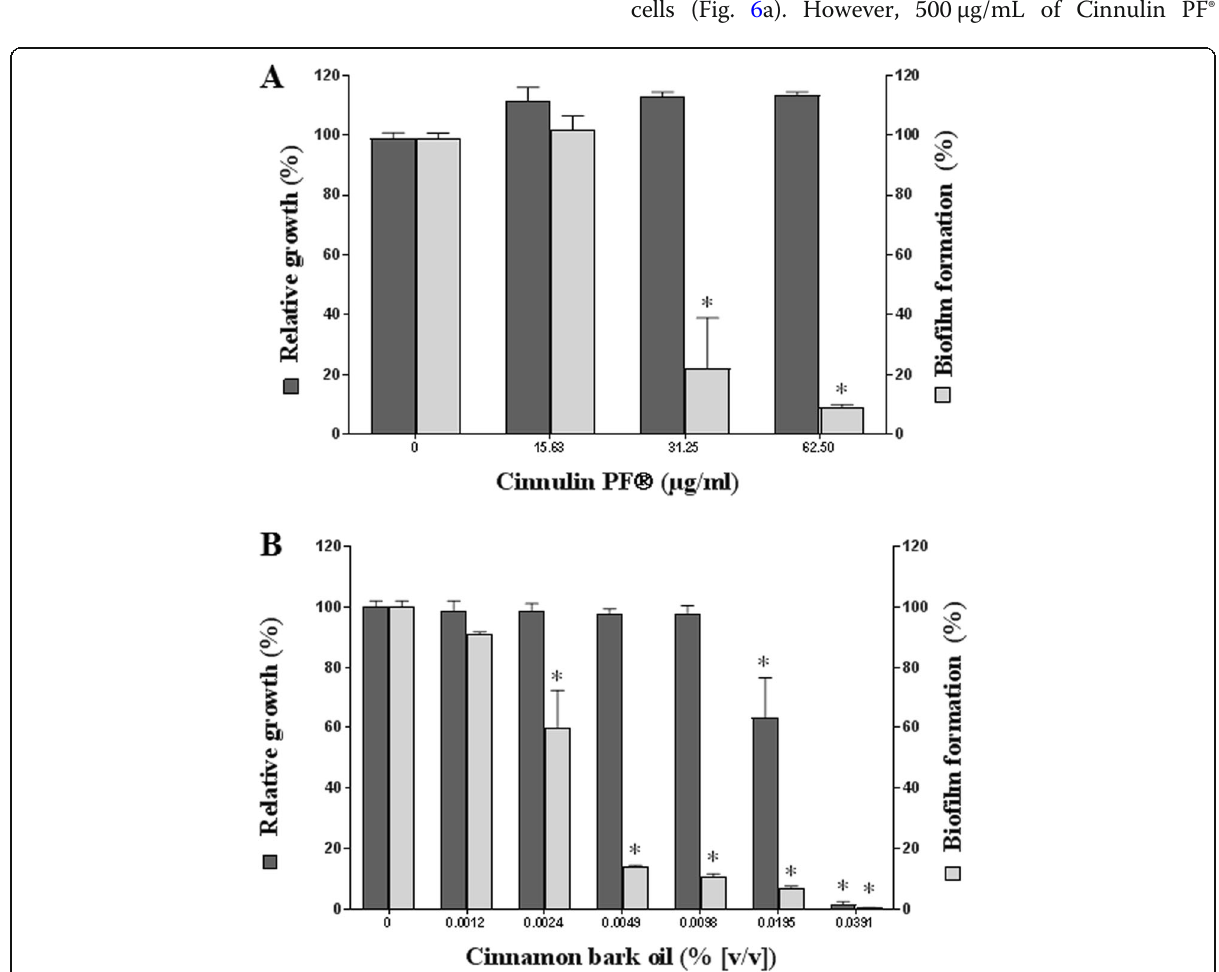
Fig. 2 Effect of Cinnulin PF® (panel a ) and cinnamon bark oil (panel b ) on the growth and biofilm formation of C. albicans ATCC 28266. A value of 100% was assigned to the growth and biofilm obtained in the absence of the cinnamon fractions. Results are expressed as the means ± SD of triplicate assays from two independent experiments. *: significantly different from the control ( p <